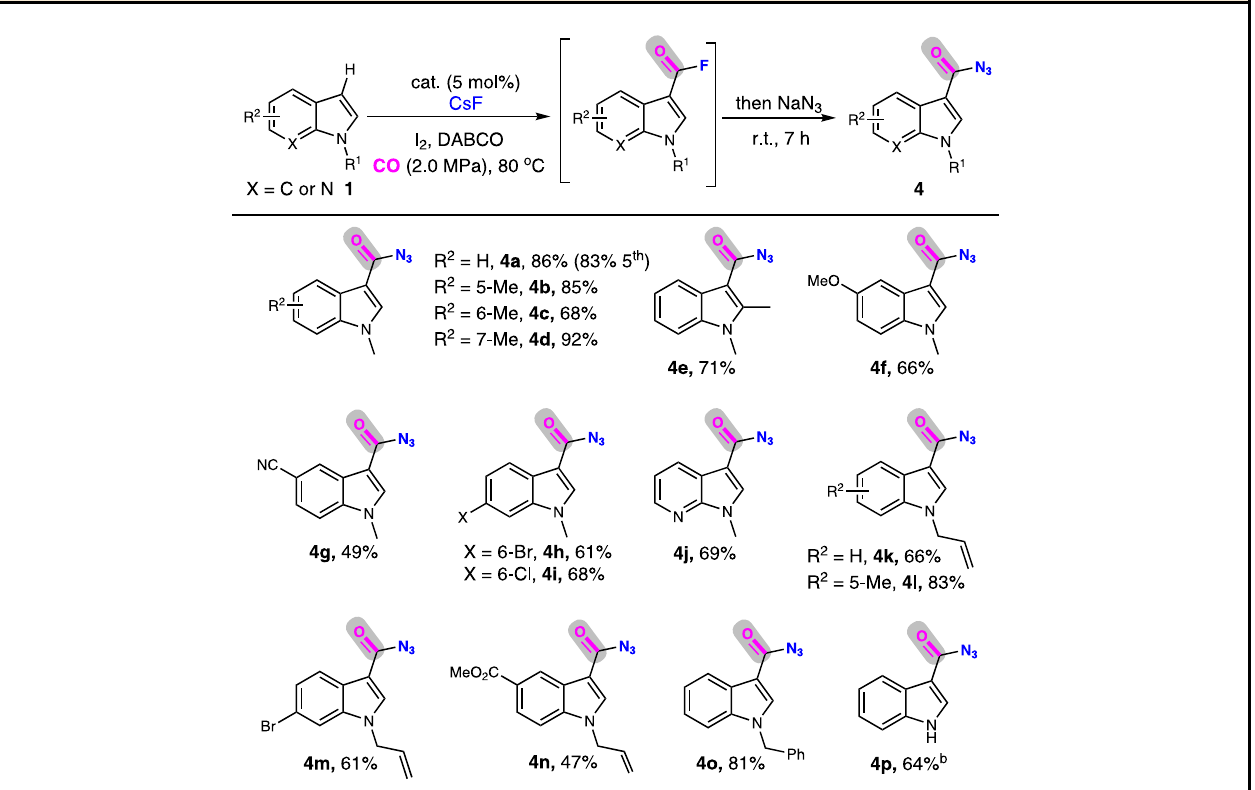
Table 3 Azidocarbonylation of indoles and their analogues to synthesize indole-3-carbonyl azides a